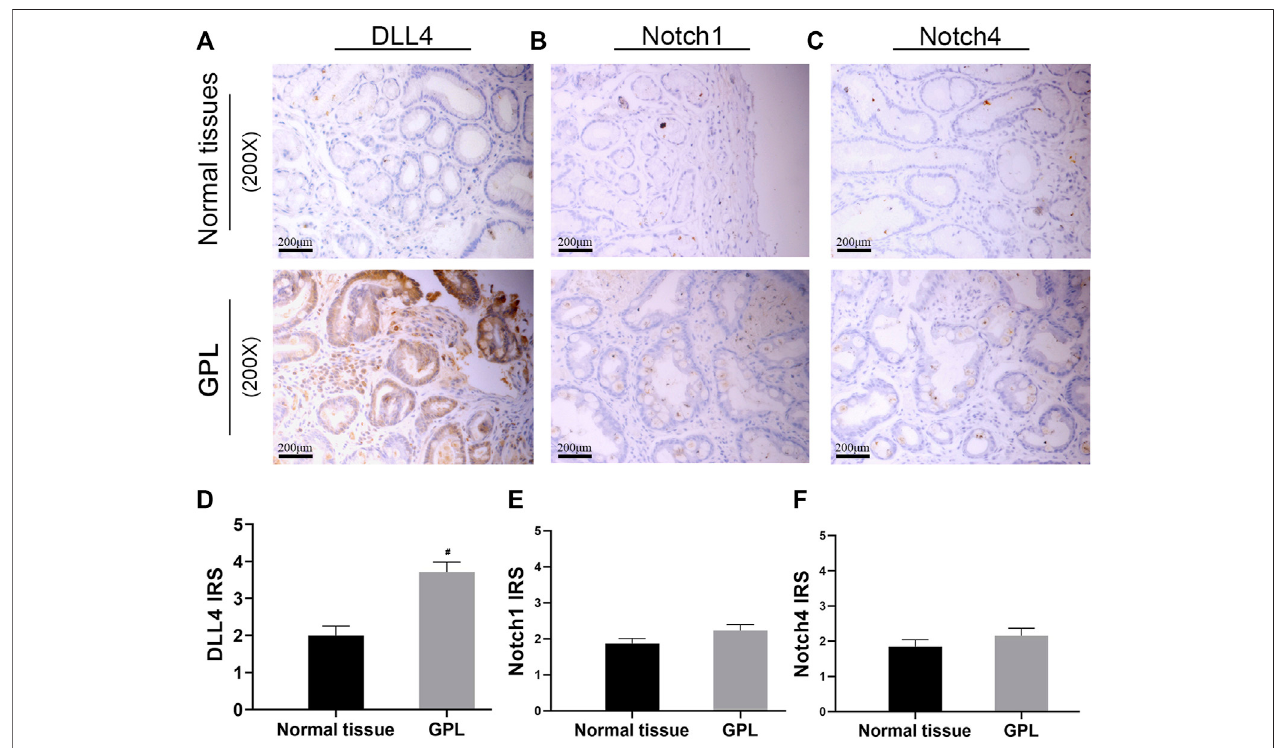
FIGURE 4 | DLL4 mRNA expression is upregulated in gastric cancer and DLL4 protein is over-expressed in human GPL specimens. Representative IHC images demonstrating the expression of DLL4 (A) , Notch1 (B) and Notch4 (C) in GPL and normal tissues (×200). Semi-quantitative analysis of DLL4 (D) , Notch1 (E) and Notch4 (F) protein expression in human specimens ( n = 102). # p < 0.05 versus the control group. Data are presented as mean ± SEM. Abbreviations: AT-III, Atractylenolide III; GPL, gastric precancerous lesions; GC, gastric cancer; IHC, immunohistochemistry; SEM, standard error of